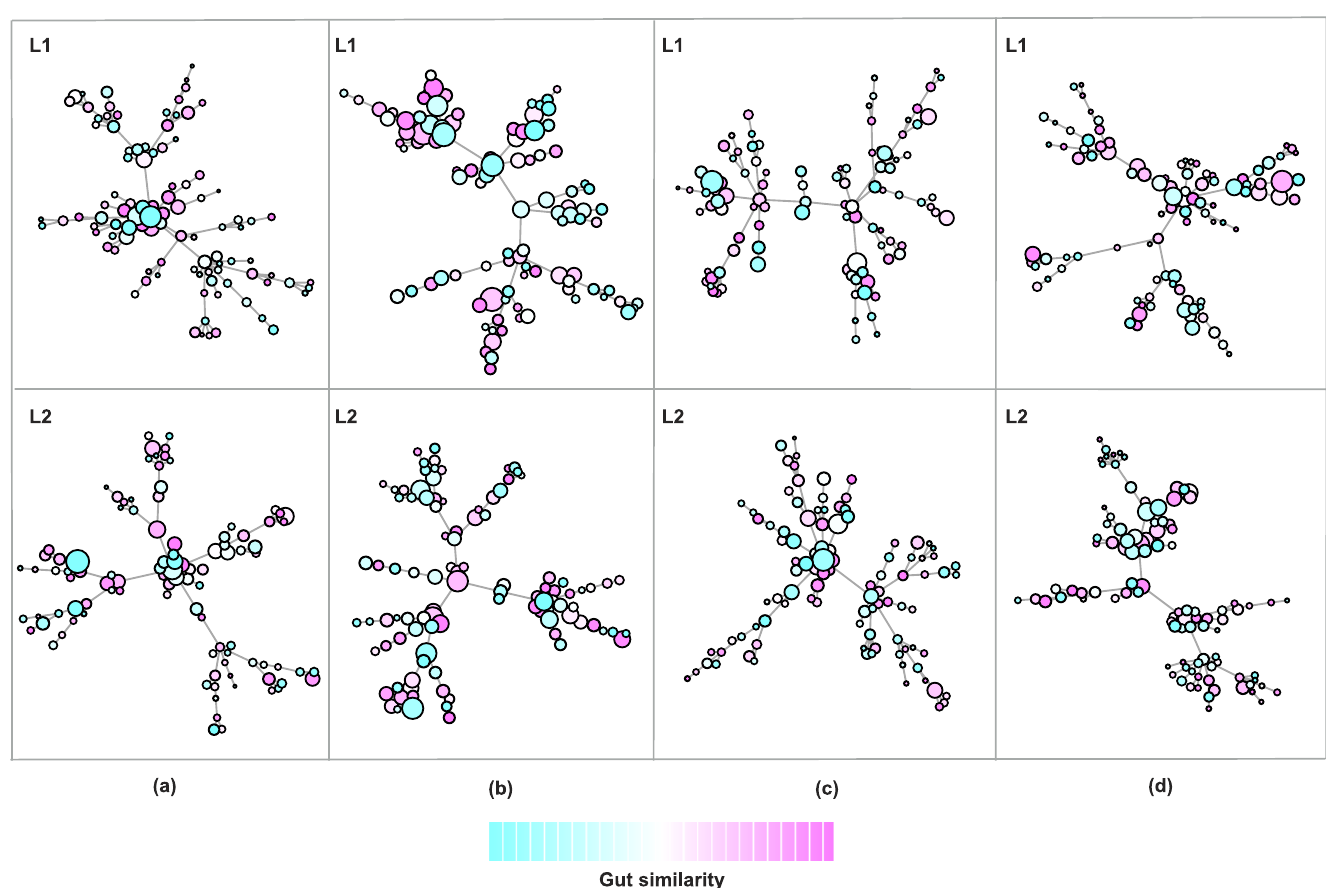
Fig 2. Structural and metabolic heterogeneity of nodes—Gut similarity and structural properties of nodes in the multiplex network. We show the heterogeneity ) among nodes in the different layers of the multiplex network ( L 1 and L 2 ), along with their structural measure of of nodes in terms of diets and gut similarity ( θ ij centrality and homophily [30]. The color, ranging from ‘light cyan’ to ‘violet’ passing through ‘white’, allows characterizing the distance among nodes in terms of gut similarity, so that the more similar are diets and gut bacterial composition, the closer will be the colors in the plot. The node size is log-proportional to the overall measure of centrality and homophily in the multiplex network [30]. For each column of the panel, we show the gut similarity before feedback (a), after the first feedback round (b), after the second feedback round(c), and after the third feedback round